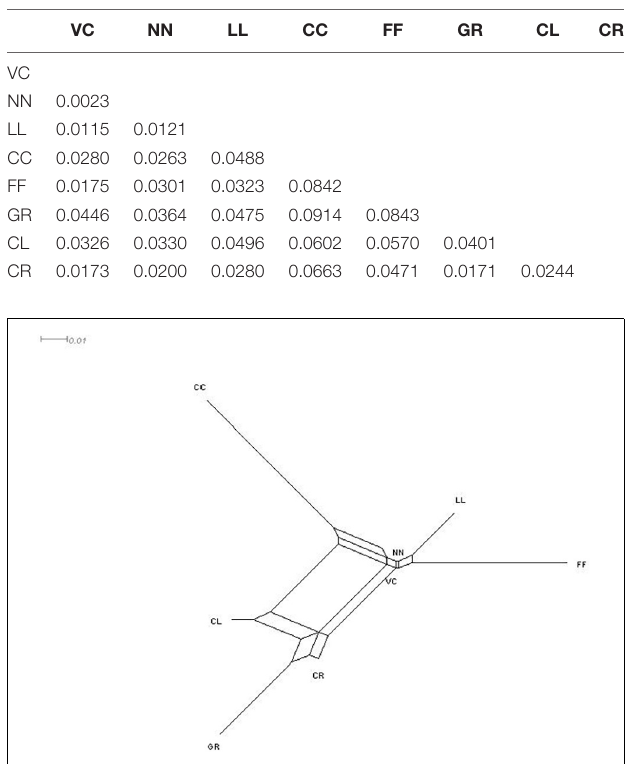
FIGURE 4 | NeighborNet tree summarizing the genetic distances between chicken phenotypes. NN, naked neck; LL, long legged; CC, crested or crown; FF, frizzle feathered; GR, Giriraj, CL, commercial layer; CR, crossbreds; VC, non-descript chicken.